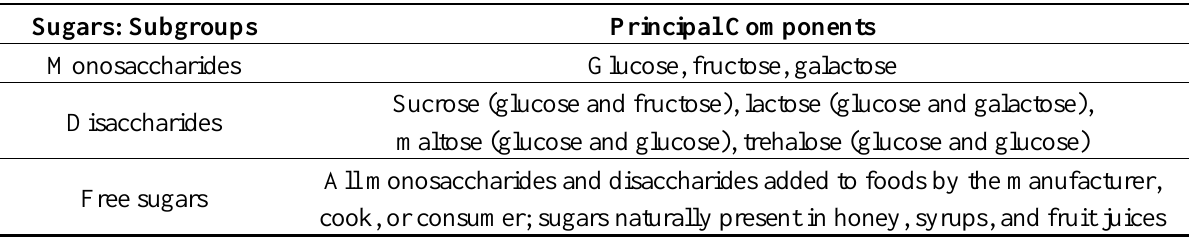
Table 1. Classification of dietary